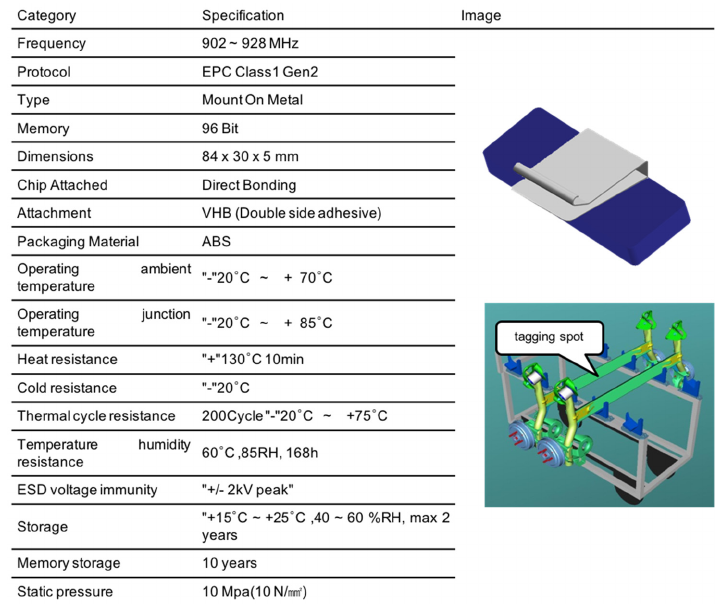
Figure 4. Specification of radio frequency identification (RFID) metal tag.